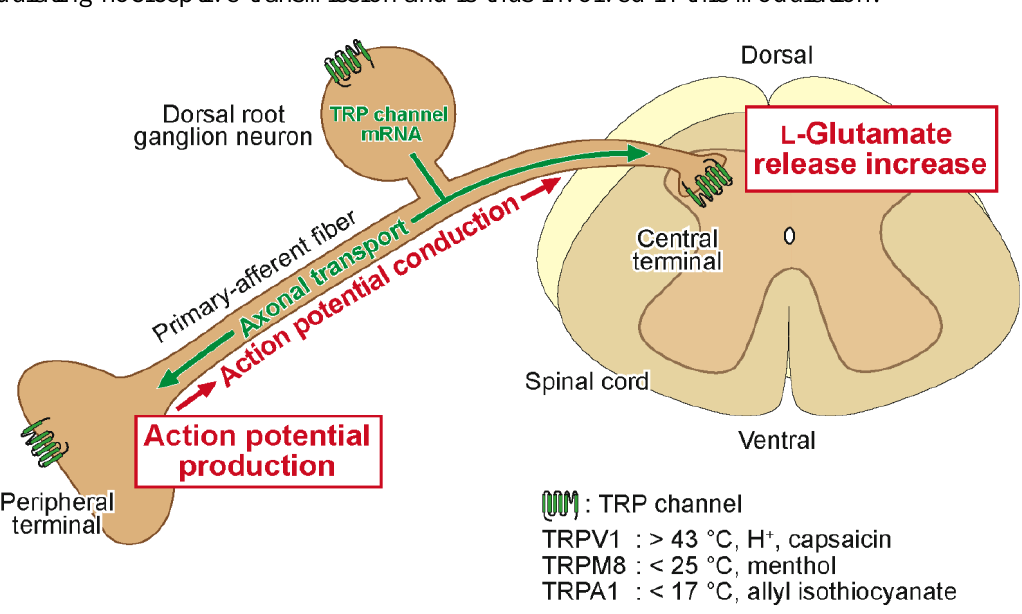
Figure 1. Schematic diagram illustrating what roles transient receptor potential (TRP) channels in the peripheral and central terminals of dorsal root ganglion (DRG; primary-afferent) neuron play in transmitting sensory information. The TRP channels are synthesized in the cell body of the DRG neuron and transferred to the terminals by axonal transport. Stimuli (such as temperature and chemicals) given to the periphery activate the peripheral TRP channel, resulting in membrane depolarization, which in turn generates action potential that transfers the stimulus information to the central terminal of the DRG neuron. On the other hand, central TRP activation enhances the spontaneous release of L -glutamate onto spinal substantia gelatinosa (SG) neurons, which play a pivotal role in modulating nociceptive transmission and is thus involved in this